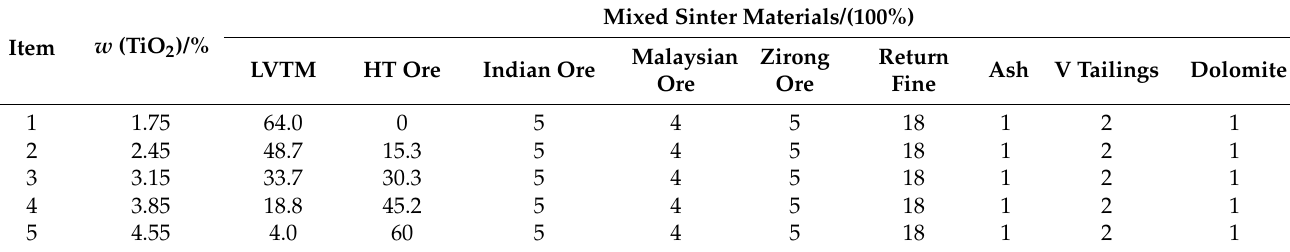
Table 4. Experimental scheme of the sinter materials.